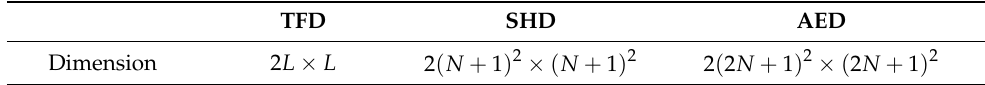
Table 1. The dimensions of the three different covariance matrices.